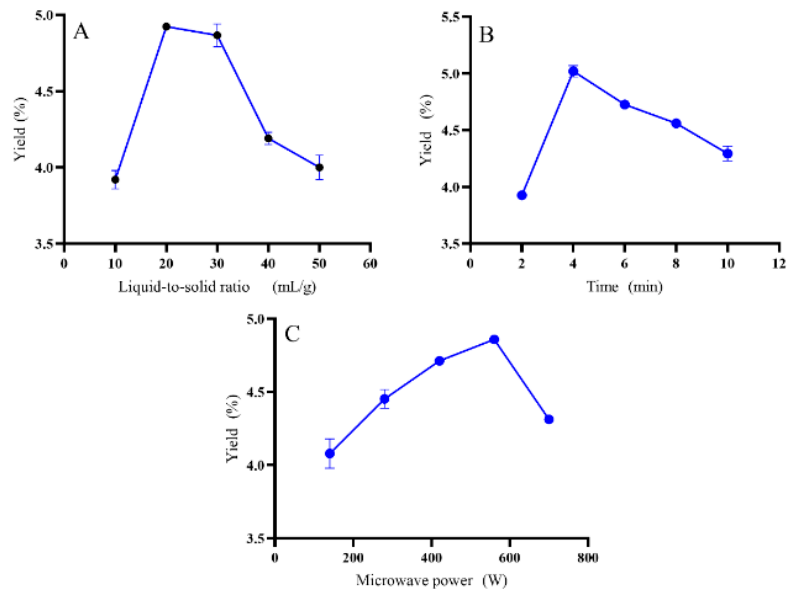
Figure 1. Effects of various factors on the yield of EO, ( A ) is the liquid-to-solid ratio factor, ( B ) is the time factor, ( C ) is the microwave power